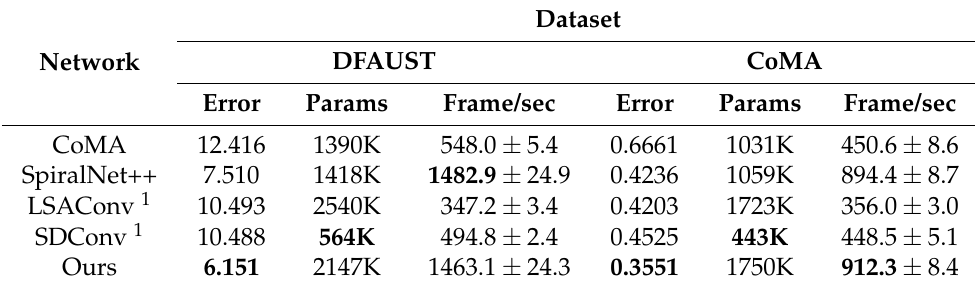
Table 2. Comparisons of the reconstruction errors, number of network parameters, and speed for CoMA, SpiralNet++, LSAConv, SDConv, and ours. All the reconstruction average errors are measured in